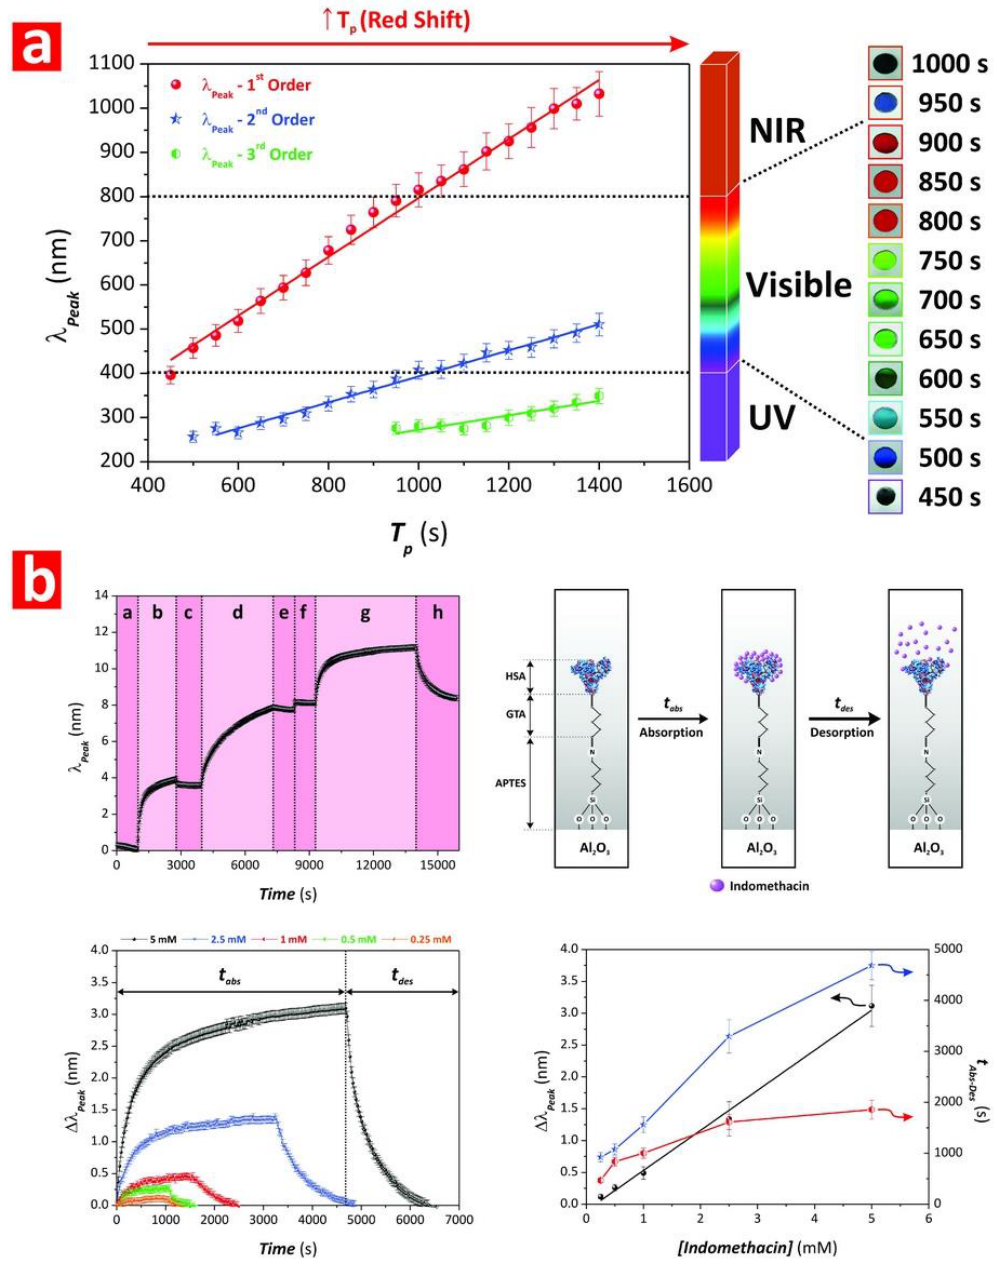
Figure 10. Examples of the applicability of NAA-PCs in chemo- and biosensing applications. ( a ) Dependence of position of PSB and anodization period of NAA-GIFs produced by SPA with digital pictures showing the interferometric colors displayed by these NAA-PCs. ( b ) Sensing process and description of sensing stages used to assess the affinity between drugs and human serum albumin using NAA-GIFs as sensing platforms. Reproduced from [77], with copyright permission from Royal Society of Chemistry, 2016.